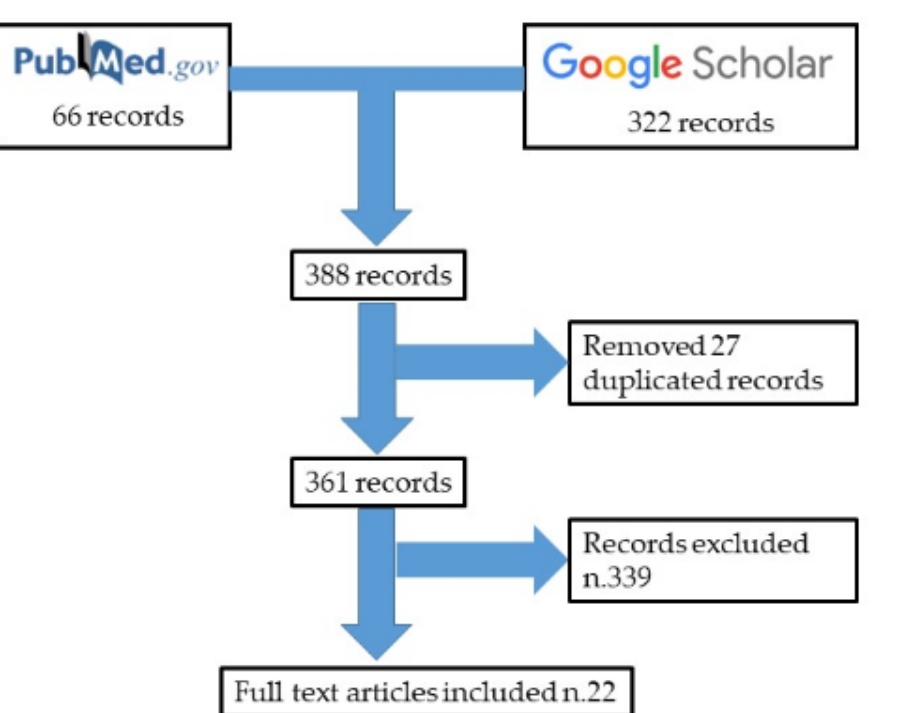
Figure 6. Flow diagram illustrating included and excluded studies in this systematic review.